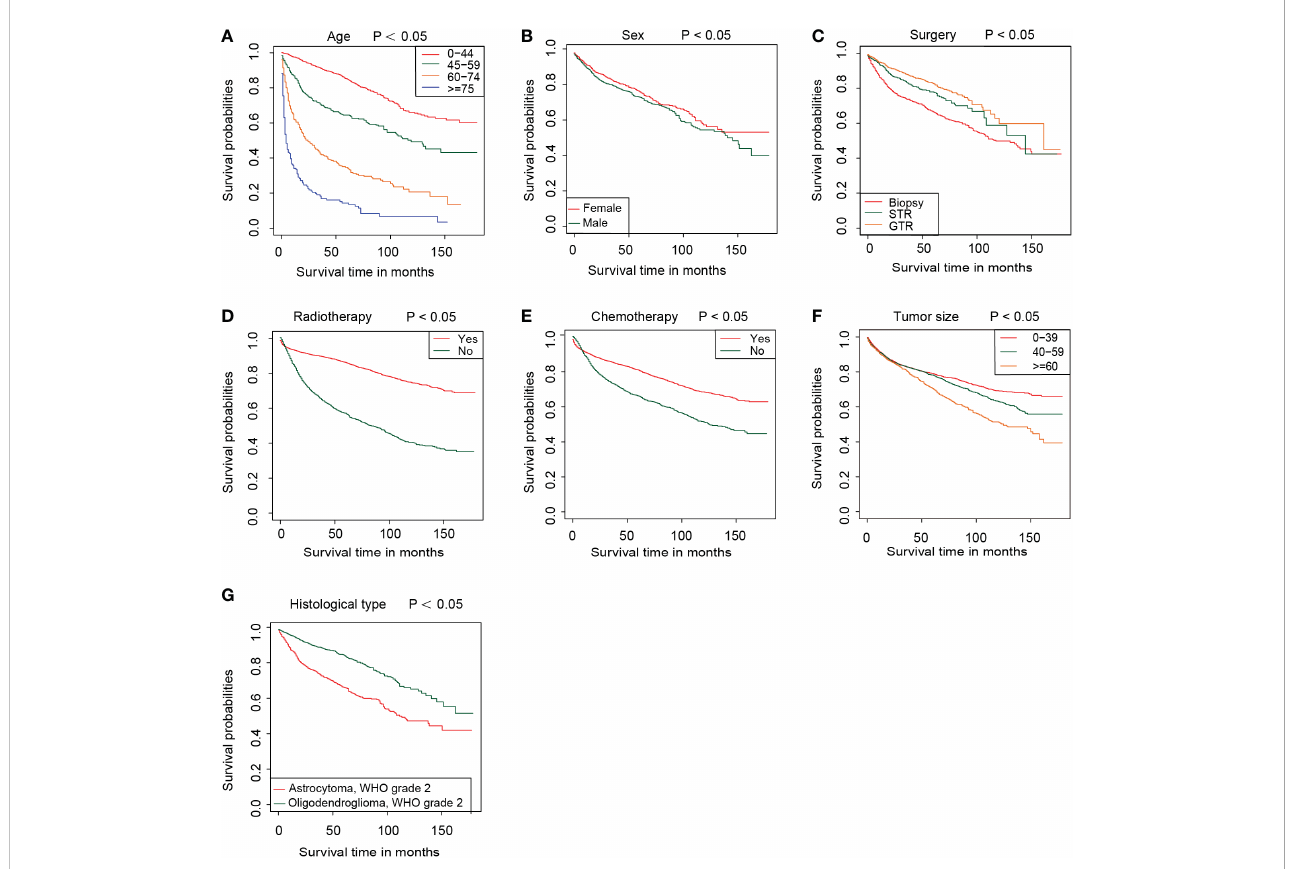
FIGURE 3 The survival curve in different subgroups, including age (A) , sex (B) , surgery (C) , radiotherapy (D) , chemotherapy (E) , tumor size (F) , and histological type (G) in the training